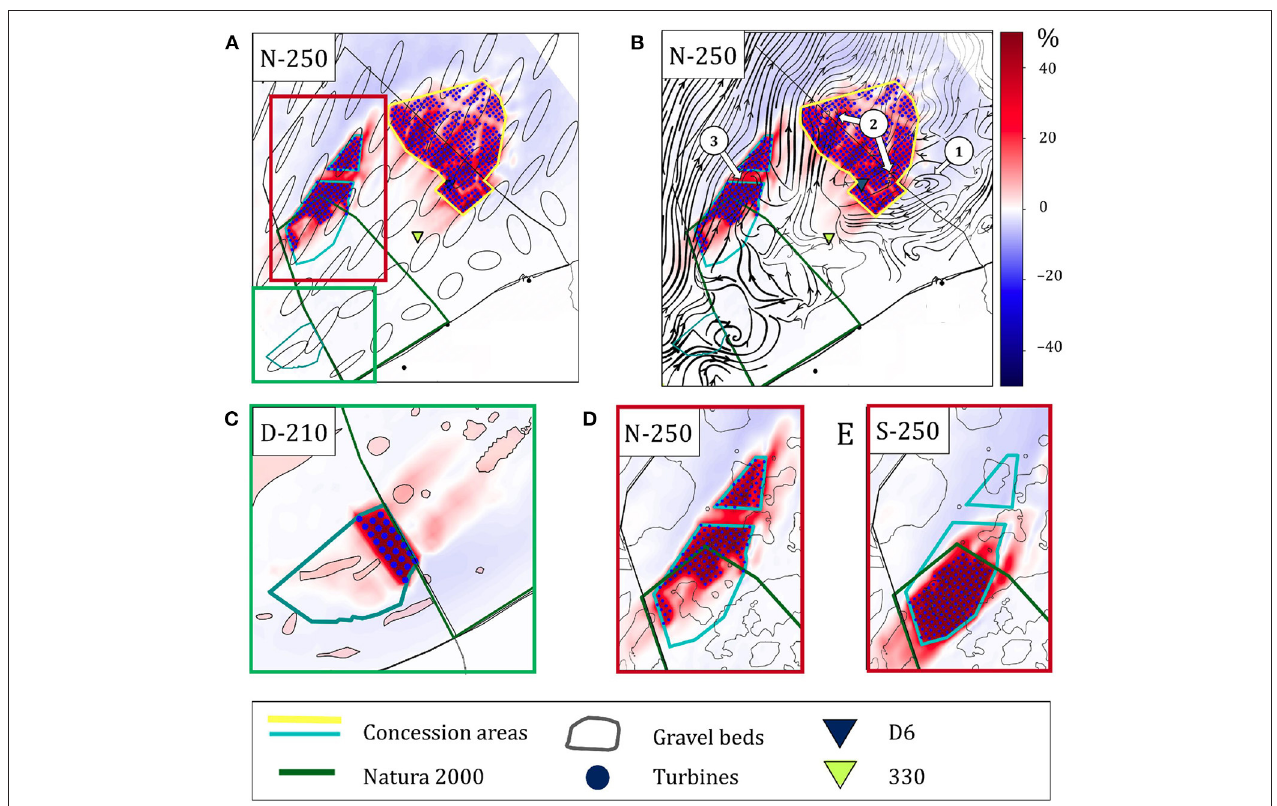
FIGURE 7 | Spatial distribution of the annual change (%) in the TOC deposition flux integrated under N-250 scenario with superimposition of the M2 tidal ellipses (A) and the residual currents (B) . Enumerated white circles denote retention gyres. In (A) the green and red rectangles correspond to cut-offs (C–E) . Each blue dot represents two monopiles. (C) Changes (in %) in the TOC deposition flux under D-210 scenario compared to R-0 simulation. Blue dots—possible location of monopiles (each dot represents 2 monopiles) and blue frame—border of Dunkirk OWF. Green polygon—Natura 2000. Pink-semi transparent polygons—gravel beds. (D,E) Change (%) compared to the R-0 simulation of yearly-integrated TOC deposition flux: N-250 case and S-250 case, respectively.